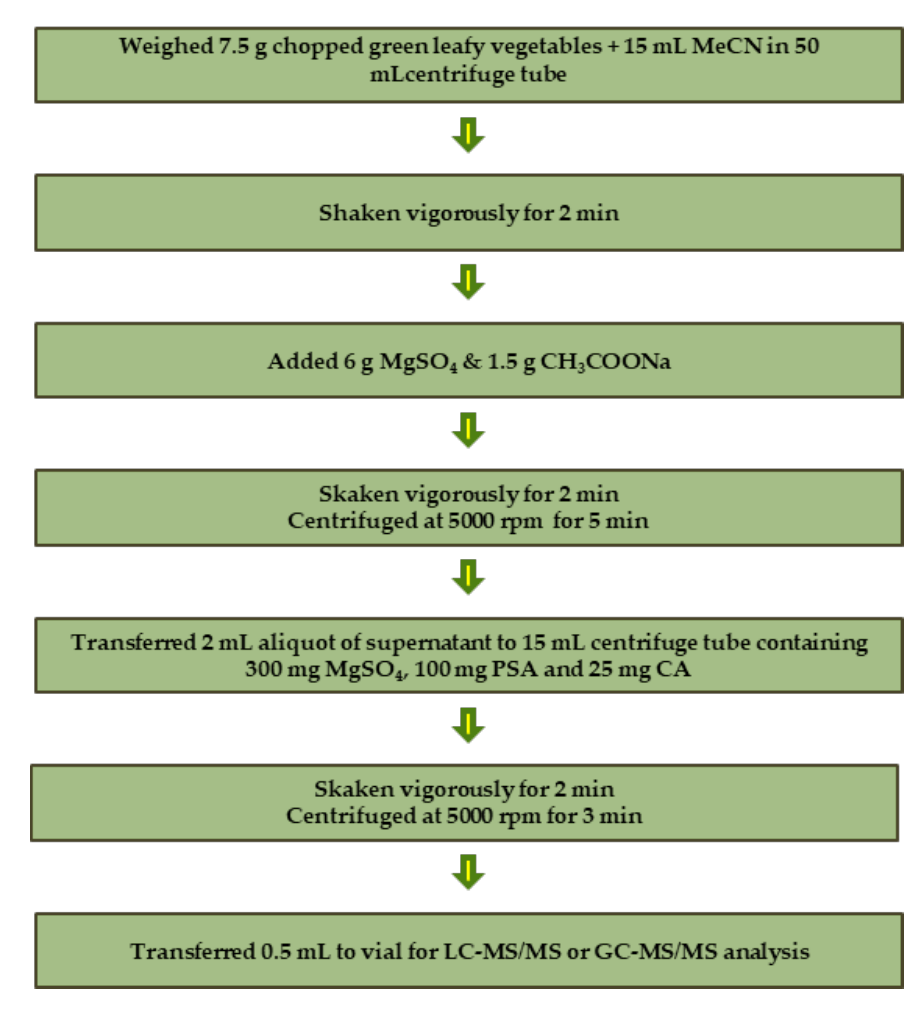
Figure 1. Schematic flow diagram of the QuEChERS sample preparation.